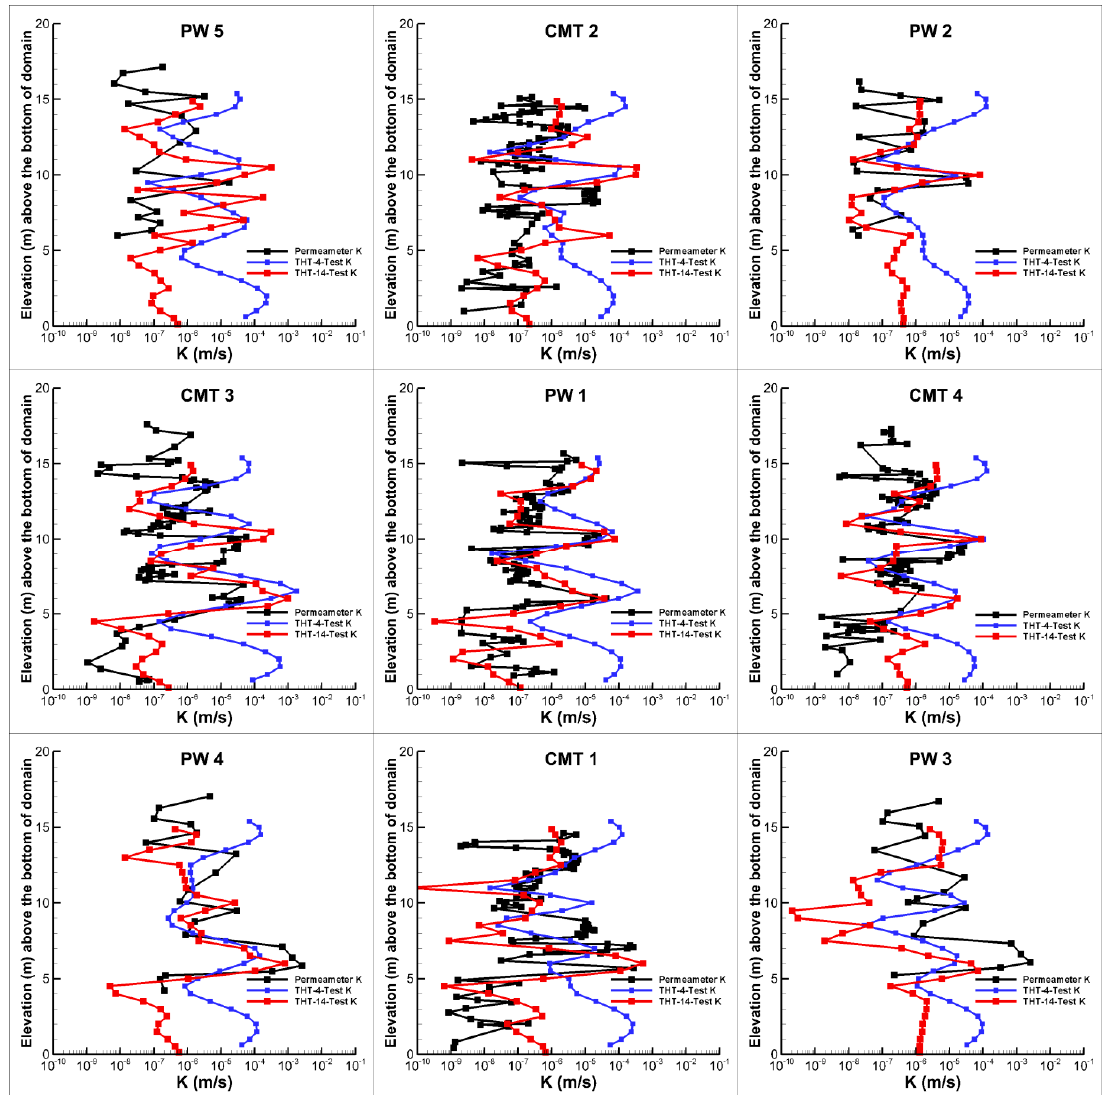
Figure 5. Vertical K profile along 9 boreholes for THT analysis with 14 pumping tests.